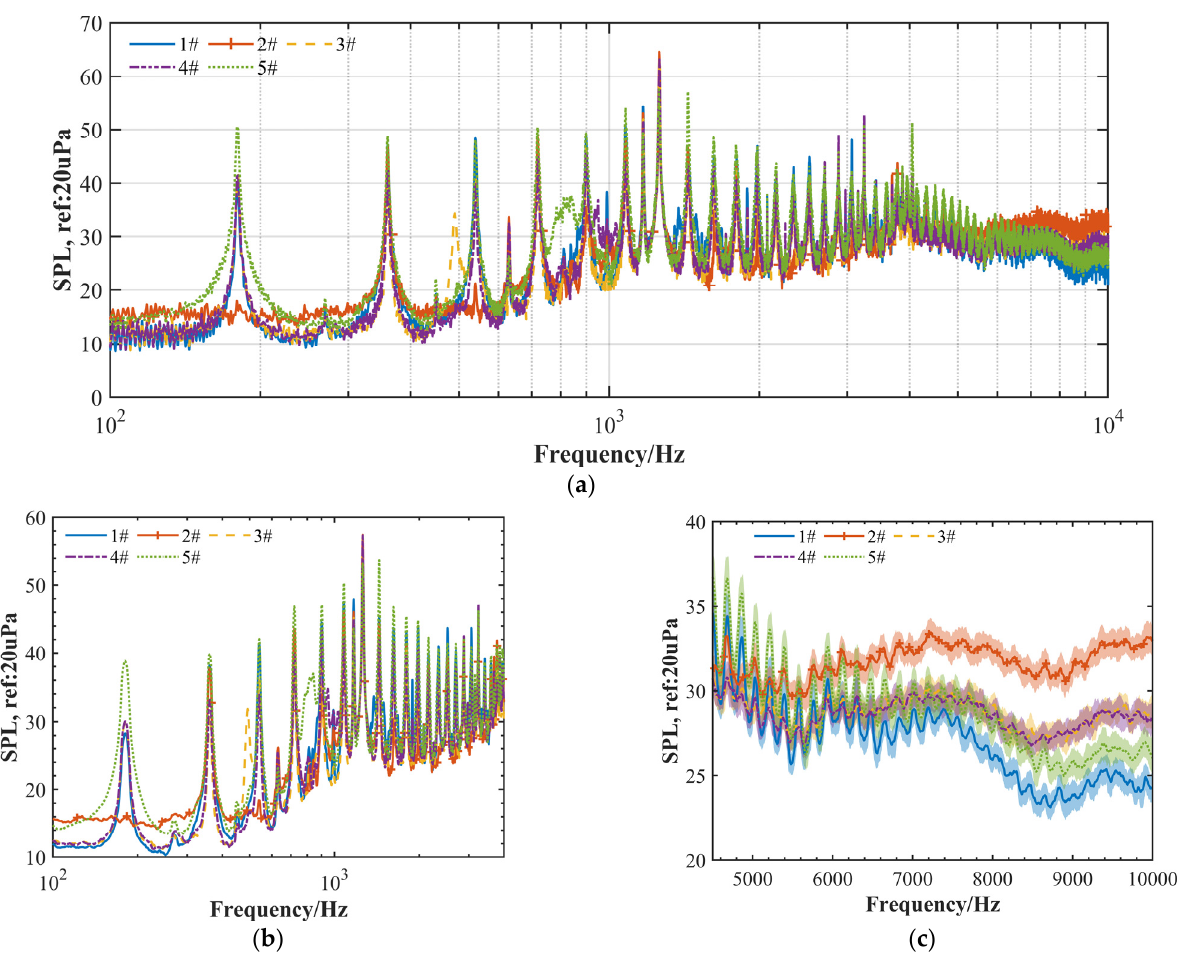
Figure 7. Power spectral density of five propellers at a rotational speed of 5400 RPM at Mic 2. ( a ) 100 Hz–20 kHz, ( b ) 100 kHz–4 kHz, and ( c ) 4.5 kHz–10 kHz.